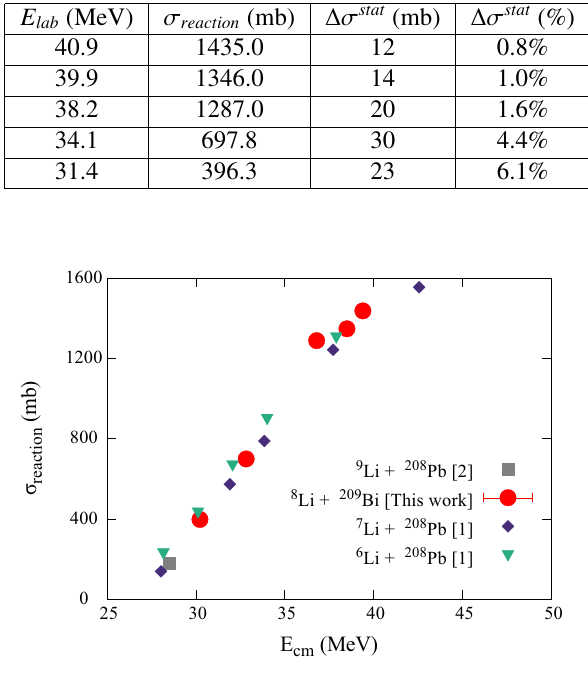
Figure 2: Reaction cross-sections and the corresponding statistical uncertainties as a function of E cm for 6 , 7 Li on 208 Pb (Keeley et al. [1]), 8 Li on 209 Bi (present data), and 9 Li on 208 Pb (Cubero et al. , [2]). Present results are